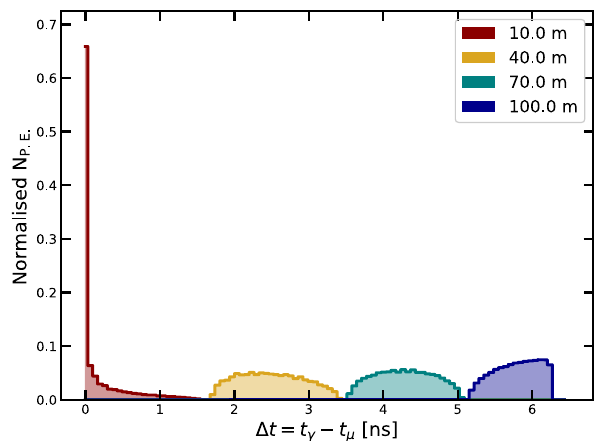
Fig. 3 Distribution of the arrival time of Cherenkov photons for a muon of energy 20 GeV and starting height 11 km as seen from several impact distances. The quantity in the y-axis is normalised for equal area at each impact